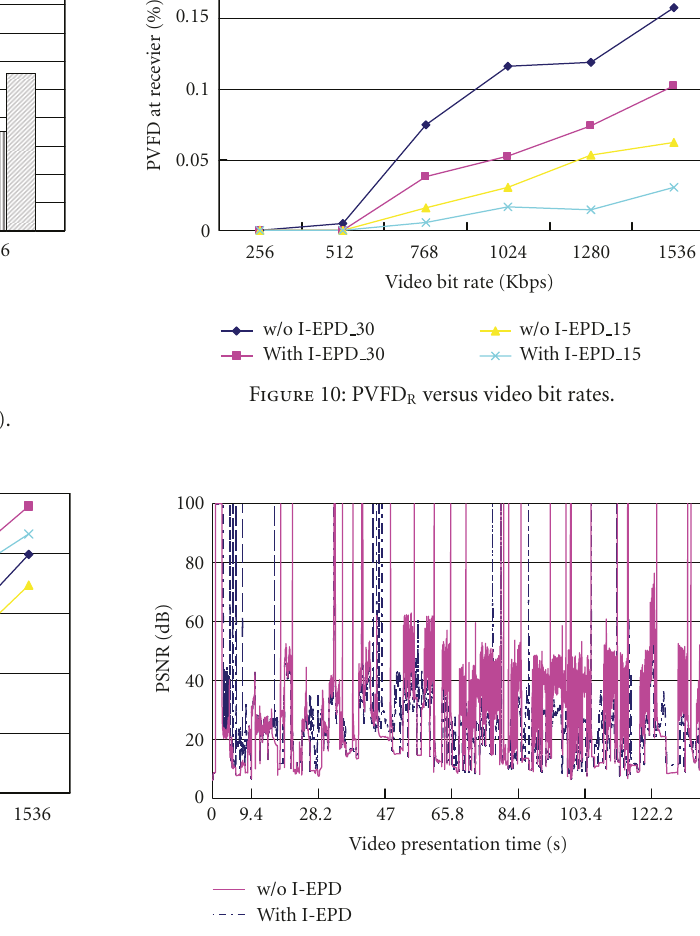
Figure 9: PVFD IN versus video bit rates.